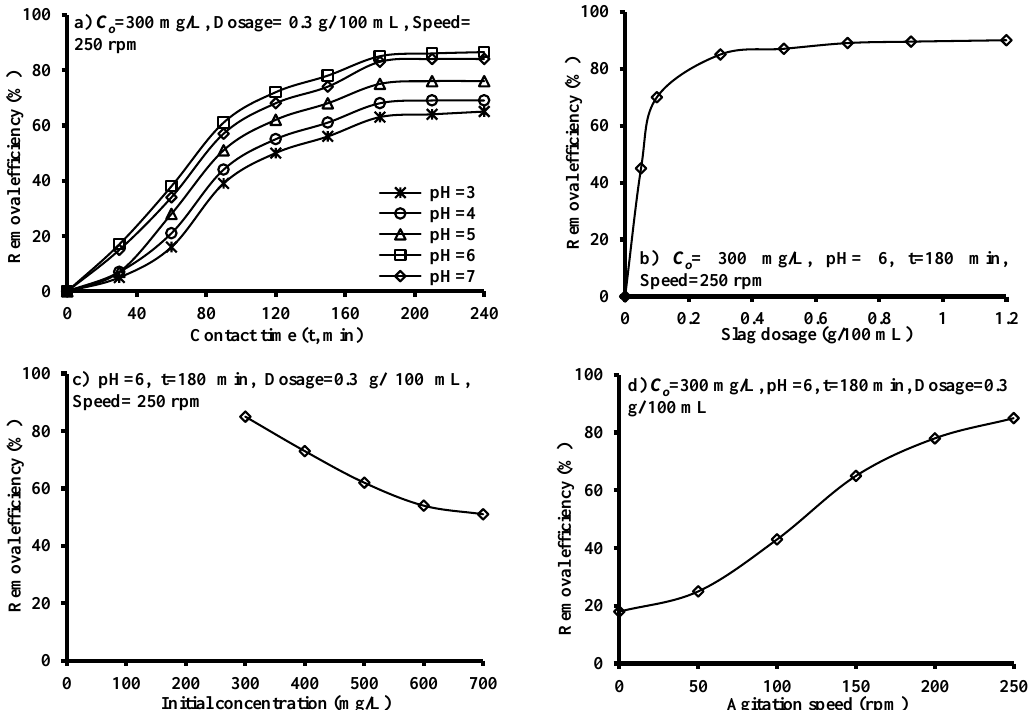
Figure 2. Effect of ( a ) contact time and initial pH, ( b ) iron slag dosage, ( c ) initial concentration and ( d ) agitation speed on the removal efficiencies of benzaldehyde from contaminated solution. Table 1. Leachate from iron slag using deionized water.